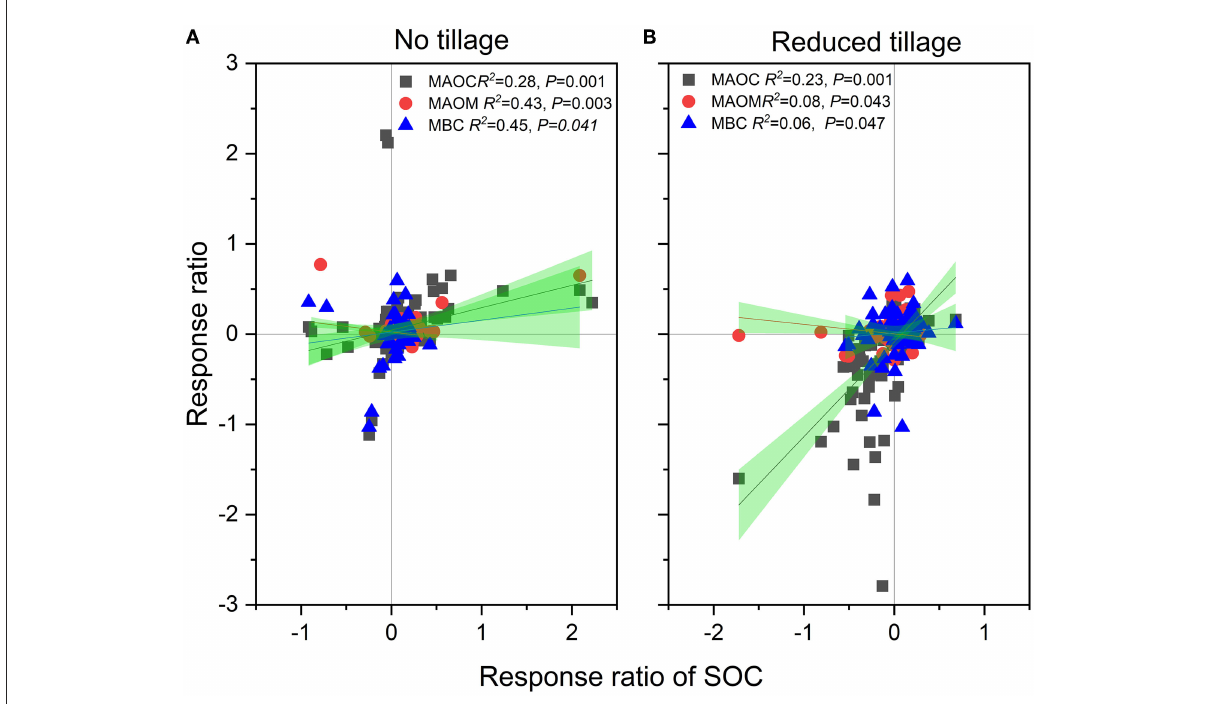
FIGURE8 (A,B) Correlations of the response ratio of MAOC, MAOM and MBC to that of